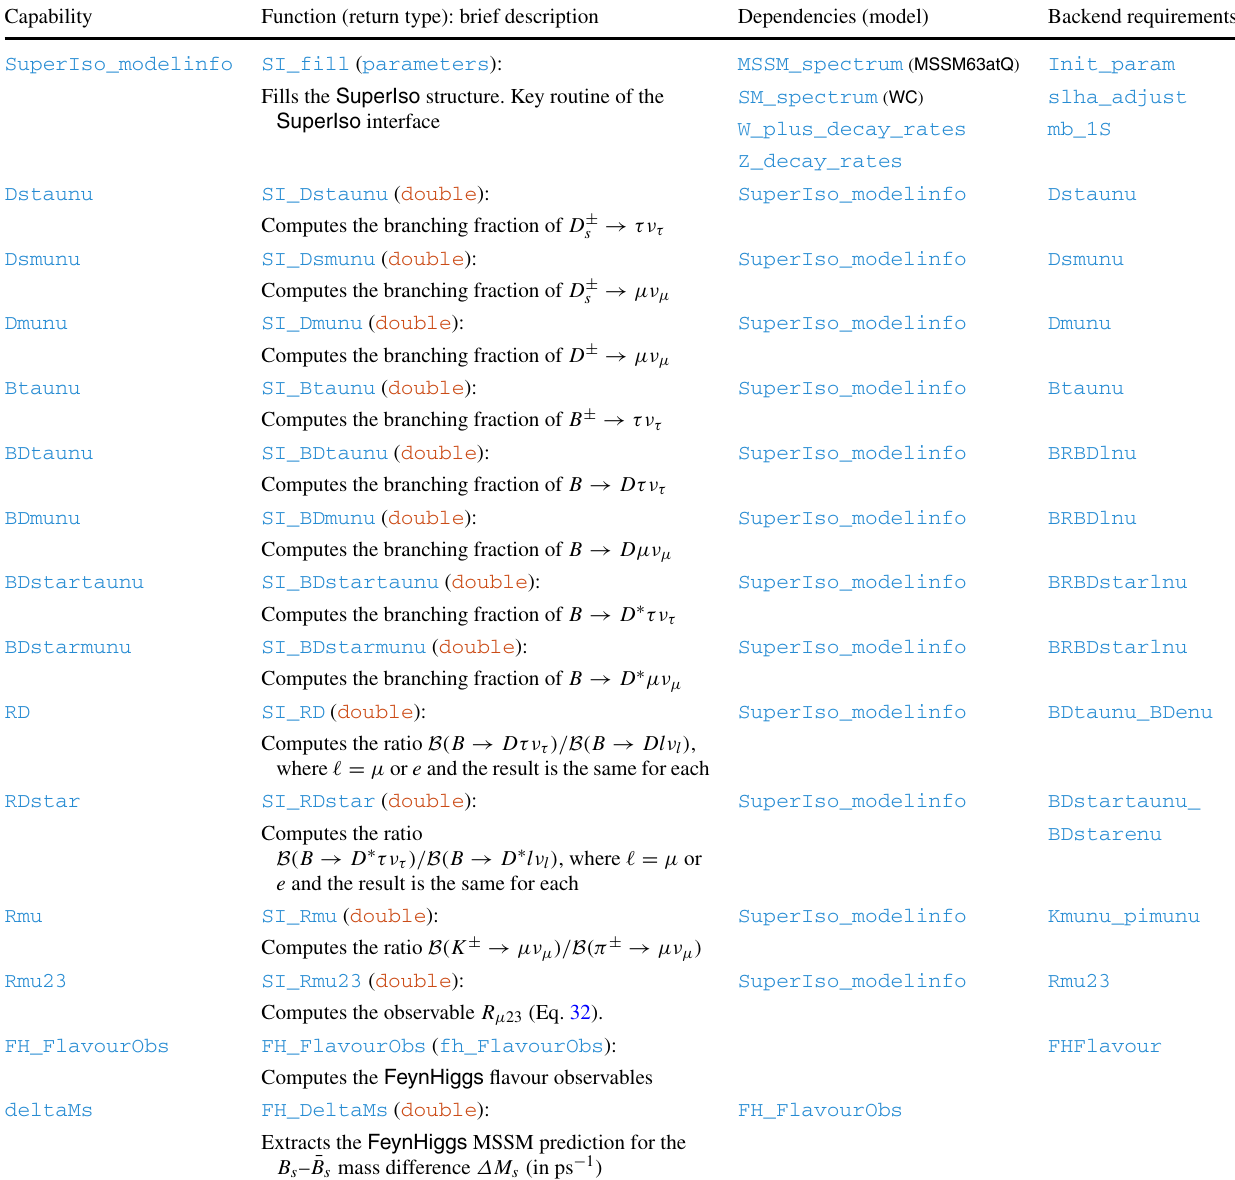
Table 1 Observable capabilities of FlavBit that do not involve Wilson coefficients. Details of the fh_FlavourObs structure can be found in Table 5